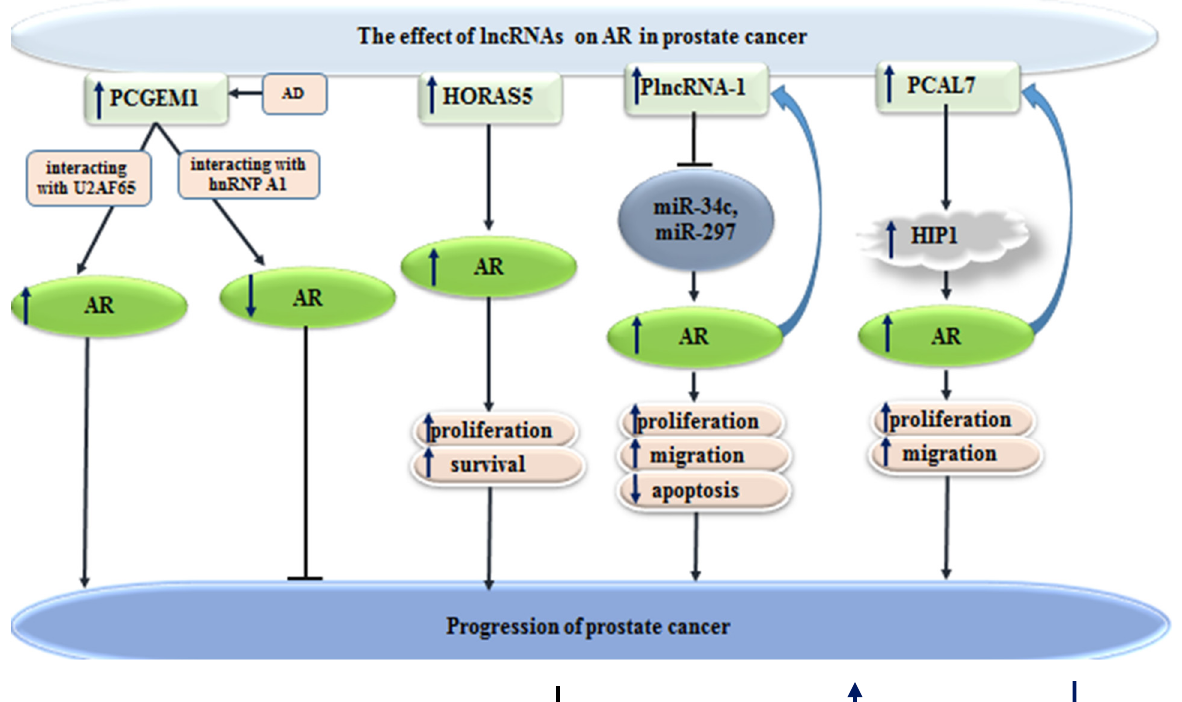
Figure 3. Effects of lncRNAs on AR in prostate cancer ( reduction or inhibition of, increased levels of, decreased levels of).